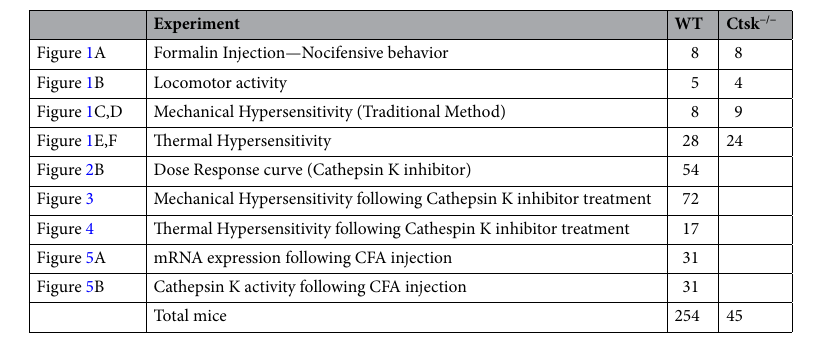
Table 1. Number of mice used per